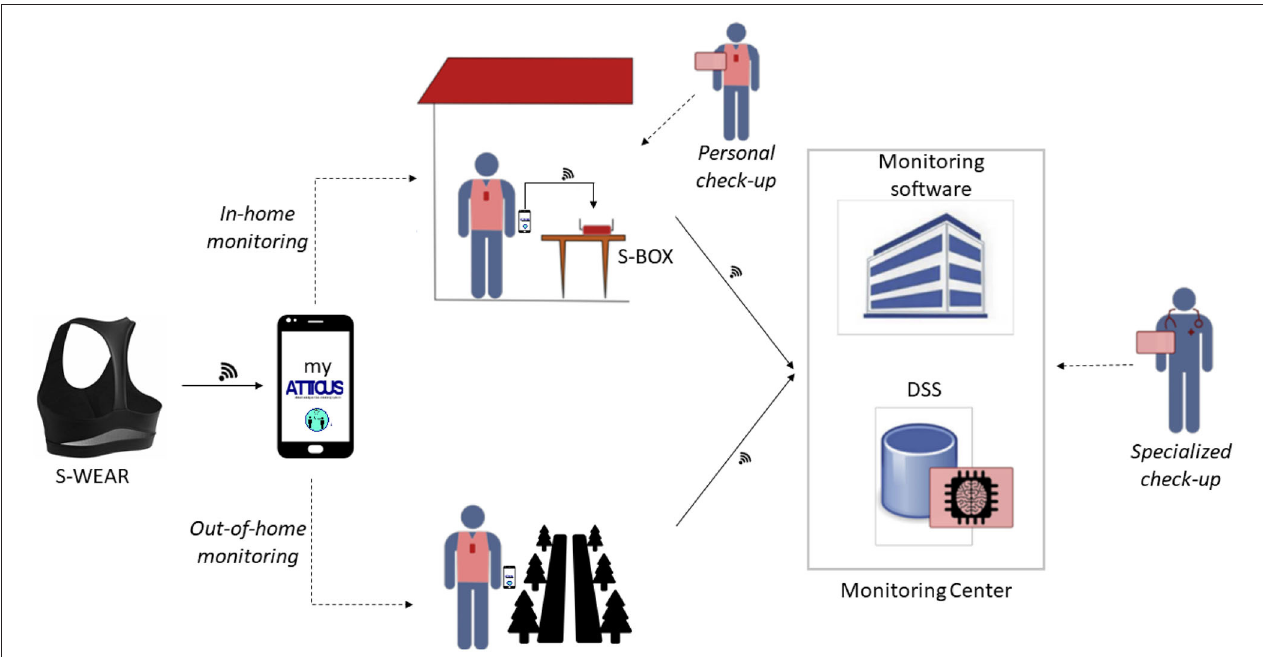
FIGURE 1 | An overview of the ATTICUS